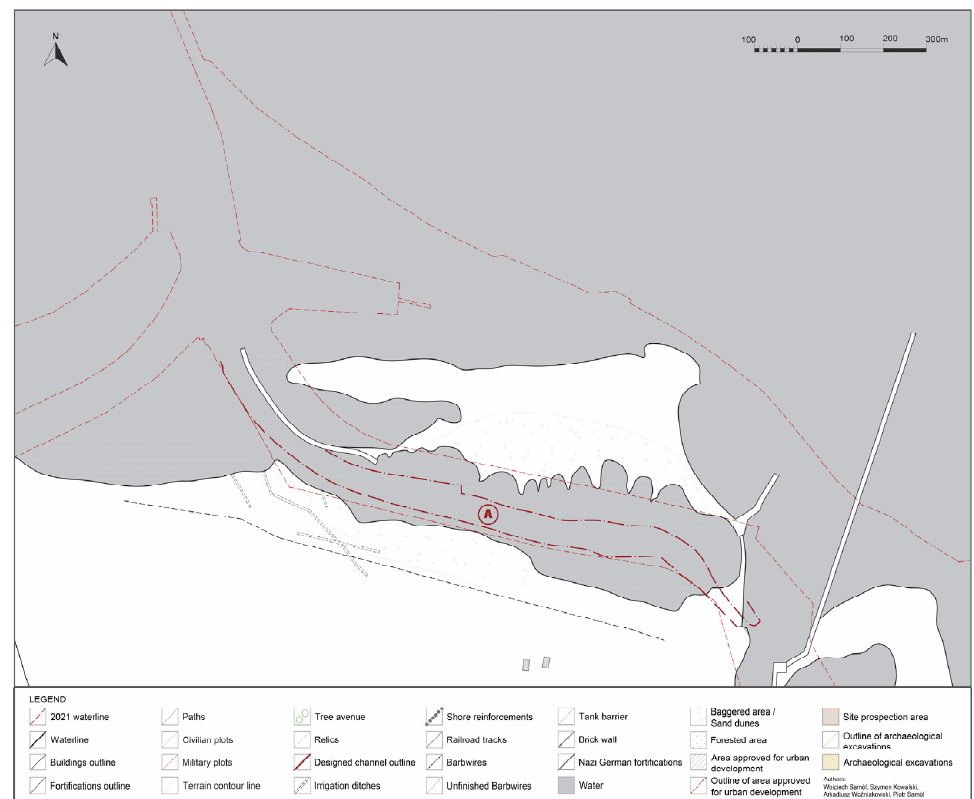
Figure 4. Westerplatte was a lagoon after